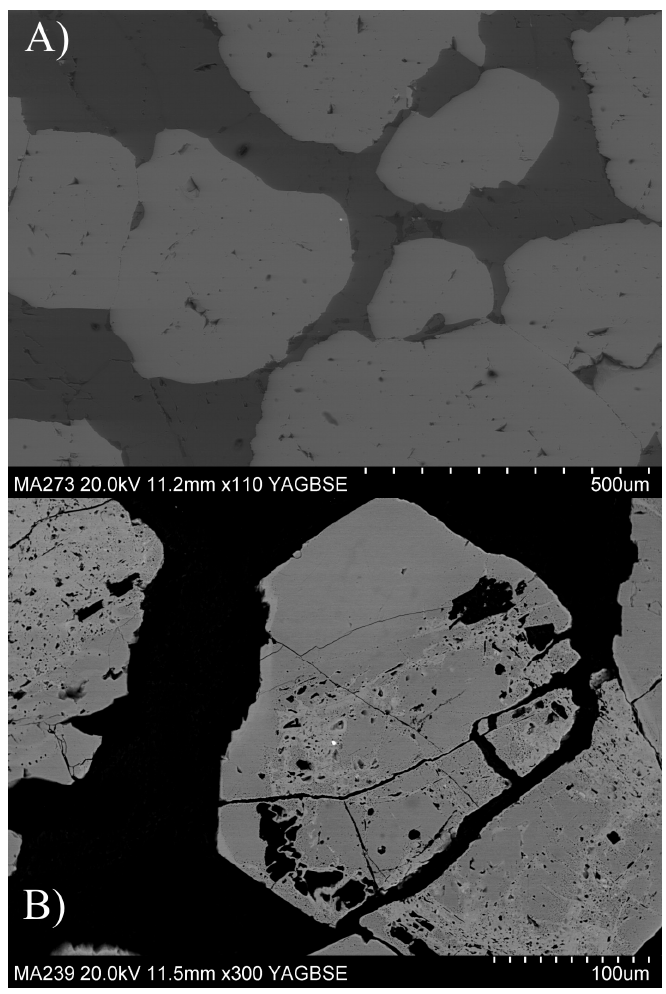
Figure 2. Electron backscattered images of textural relationships in Cr-bearing spinels from amphibole-chromitite ( A ) and chlorite-chromitite ( B